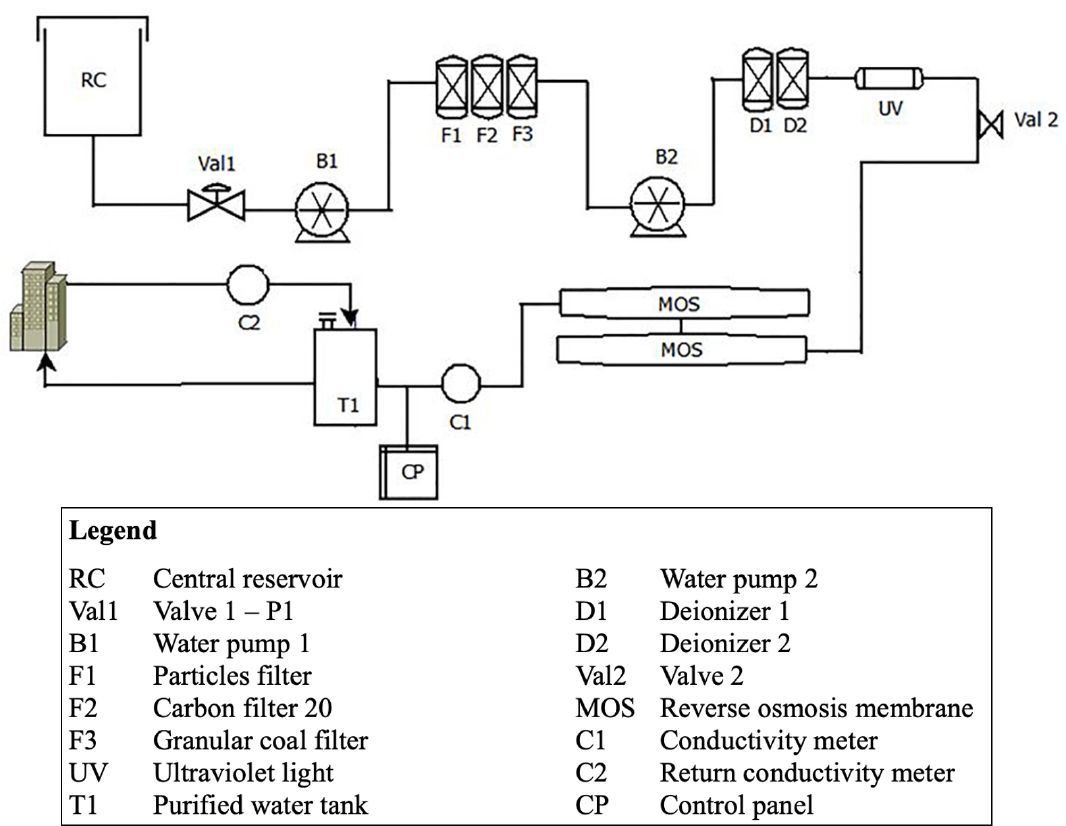
FIGURE 2 - Schematic diagram of double pass reverse osmosis water treatment system in a pharmaceutical pilot